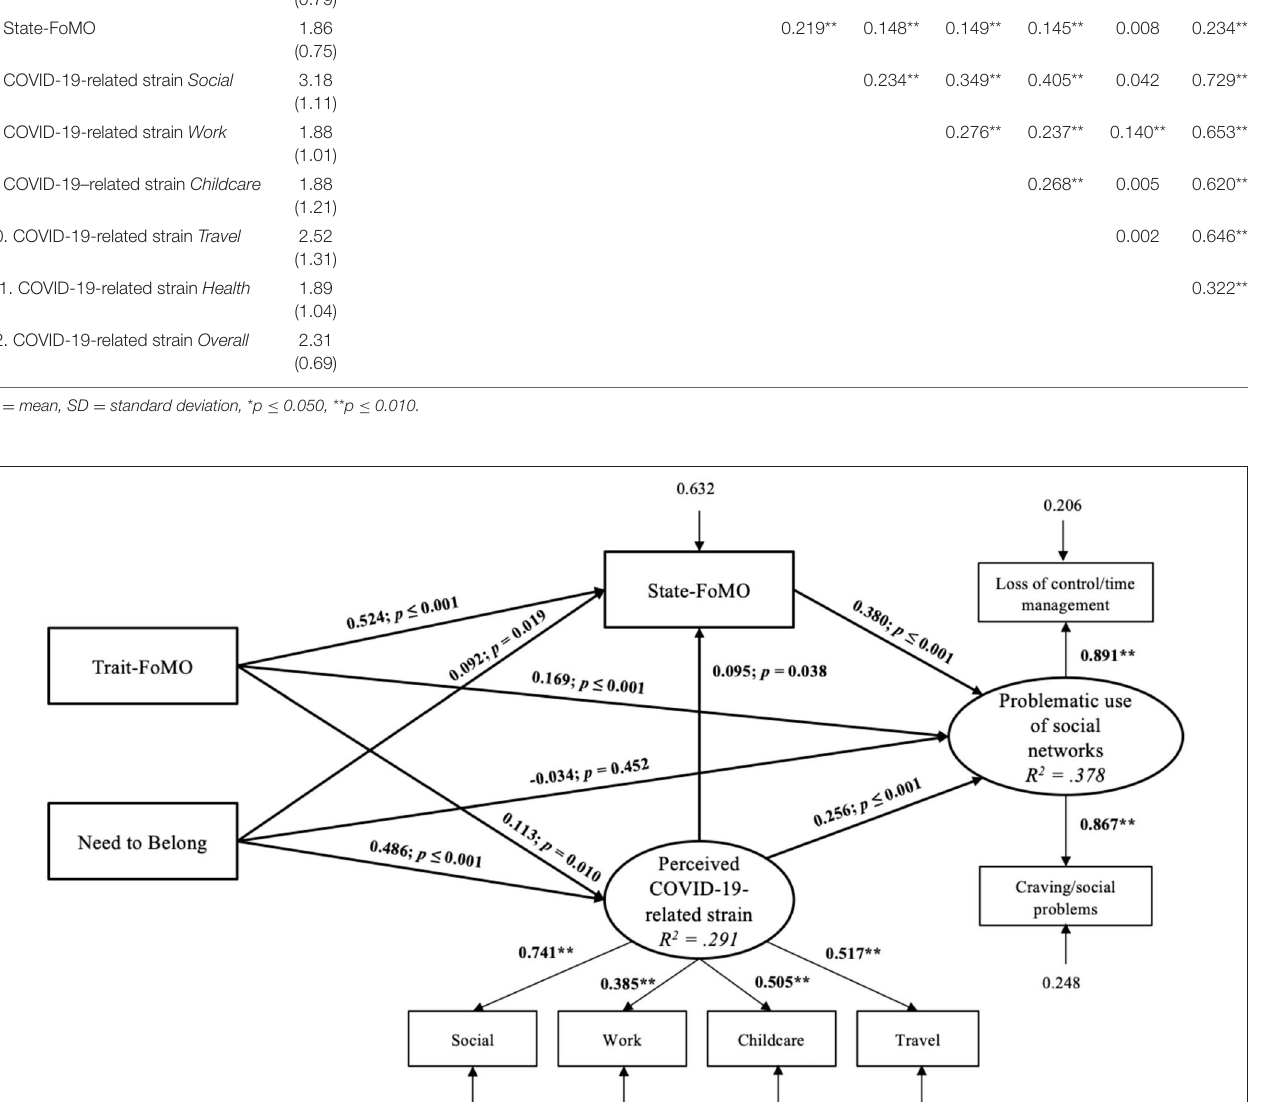
Frontiers in Psychiatry |